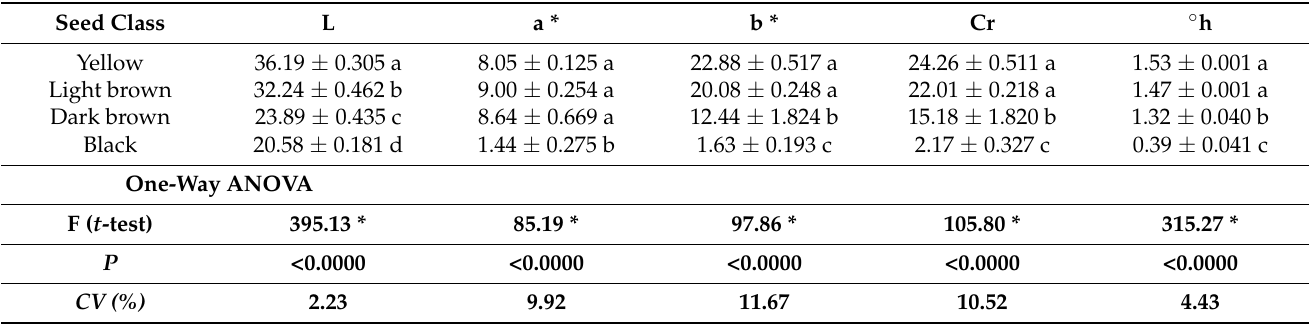
Table 1. Luminosity (L), color index “a” (a), color index “b” (b), chroma (Cr) and hue color angle (°h) in Pterodon pubescens seeds, subjectively categorized into different integument color classes.